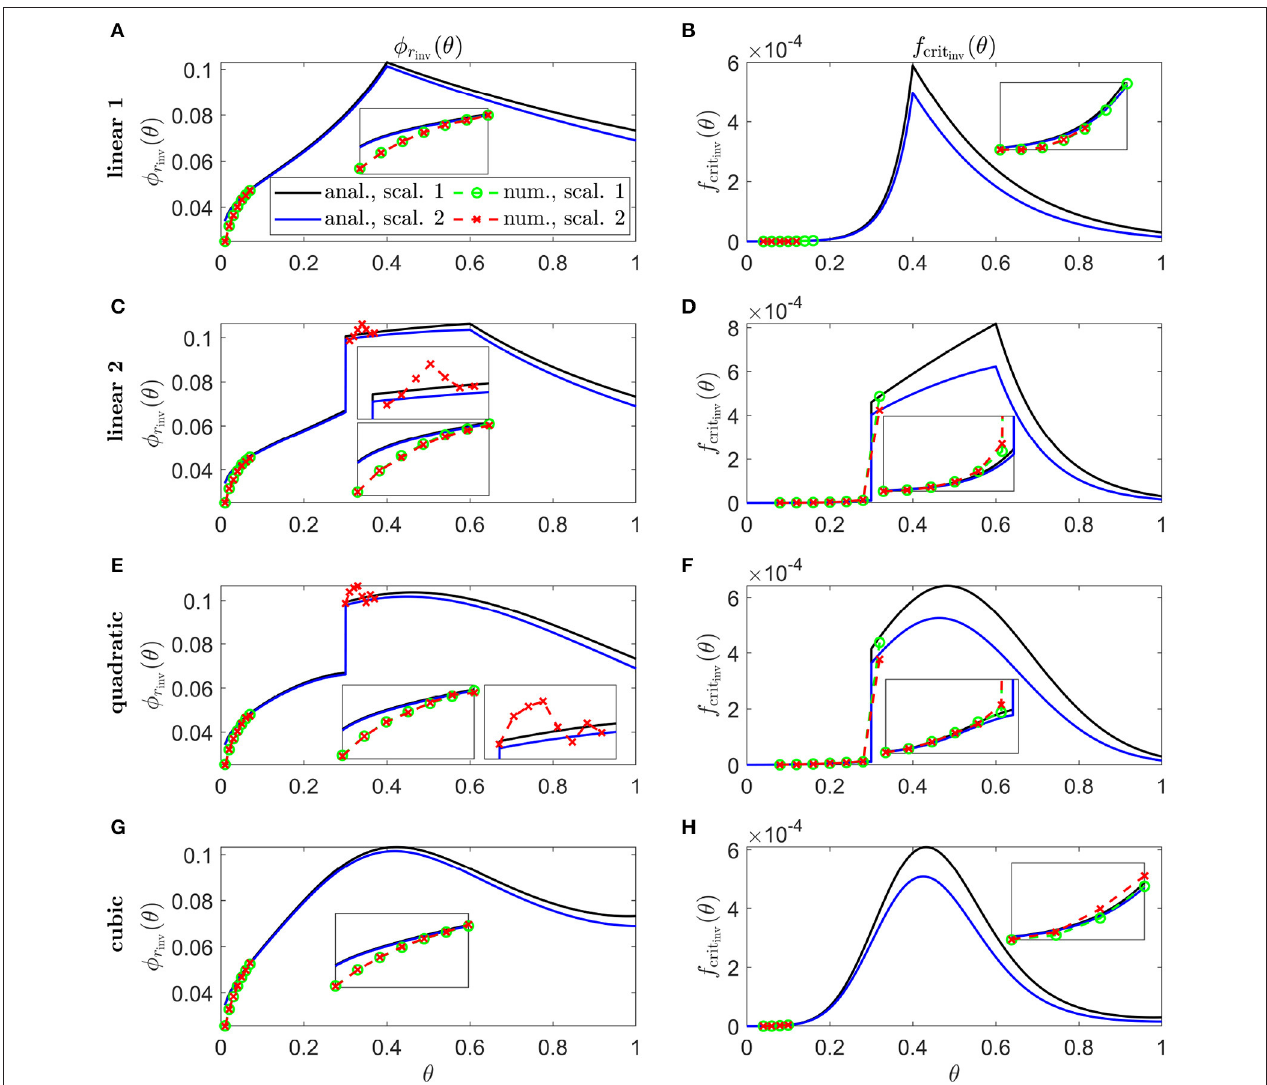
FIGURE 9 | Inverse mutation-induced rod degeneration rate and TF threshold concentration—Pattern 3 target cone degeneration profiles. (A,C,E,G) inverse ( θ ) ( φ r = 7.33 × 10 − 2 ). (A,B) linear 1 target cone mutation-induced rod degeneration rate, φ r ( θ ) ( f crit = 3 × 10 − 5 ); (B,D,F,H) inverse TF threshold concentration, f crit inv inv degeneration profile, t degen ( θ ); (C,D) linear 2 t degen ( θ ) profile; (E,F) quadratic t degen ( θ ) profile; (G,H) cubic t degen ( θ ) profile. The solid black and dashed green curves correspond to Scaling 1 ( α = 7.01 × 10 4 and β = 1.79 × 10 6 ), while the solid blue and dashed red curves correspond to Scaling 2 ( α = 7.01 × 10 2 and β = 1.79 × 10 4 ). The black and blue solid curves are analytical approximations to the inverses, obtained by plotting Equations (7) and (10) respectively (A,C,E,G) , and Equations (8) and (11), respectively, (B,D,F,H) . The green and red dashed curves are numerical inverses, obtained by using the Matlab routines fminsearch (A,C,E,G) , and patternsearch (B,D,F,H) to calculate the φ r and f crit profiles for which the contour described by p c ( θ , t ) / ˜ p c ( θ ) = 0.99 matches the target cone degeneration profile, t degen ( θ ). Equations (1–5) were solved at each iteration using the method of lines, with 26, 51 or 101 mesh points. Insets show magnified portions of each graph. Numerical inverses are calculated and plotted only at those locations (eccentricities) where the analytical inverse fails to generate a t degen ( θ ) profile matching the target profile. Inverses resemble vertically flipped versions of the t degen ( θ ) profiles. Numerical solutions reveal lower values of the inverses near the fovea ( θ = 0) than the analytical approximations suggest and higher values in some regions away from the fovea in (C–F,H) . Cone degeneration profile formulas and parameters are given in Table 3 . Remaining parameter values as in Table 2